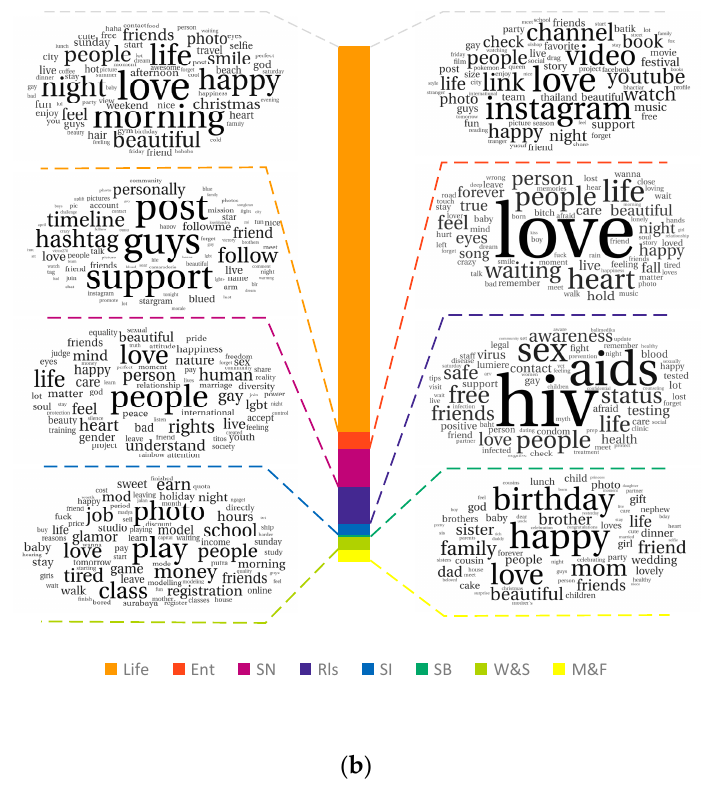
Figure 3. Word cloud of the eight categories of ( a ) Chinese and ( b ) English topic data.